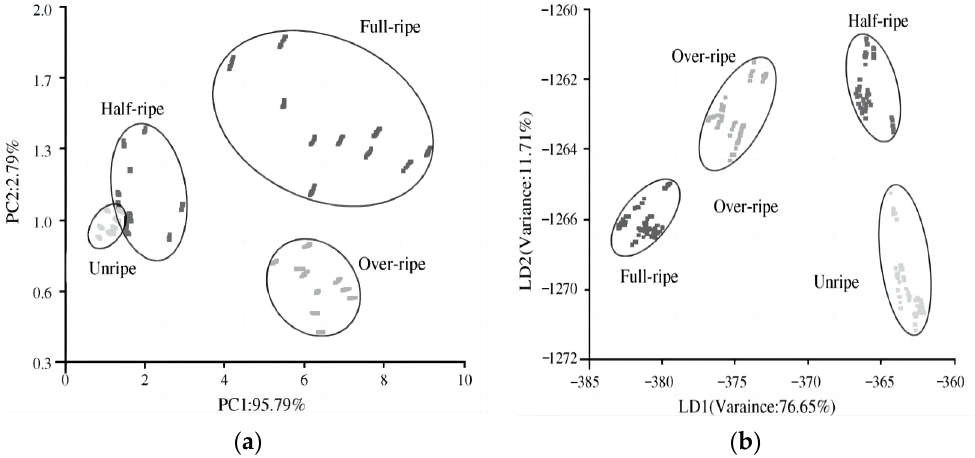
Figure 4. Results of tomato ripeness from two analysis methods: ( a ) PCA; ( b ) LDA. Reprinted with